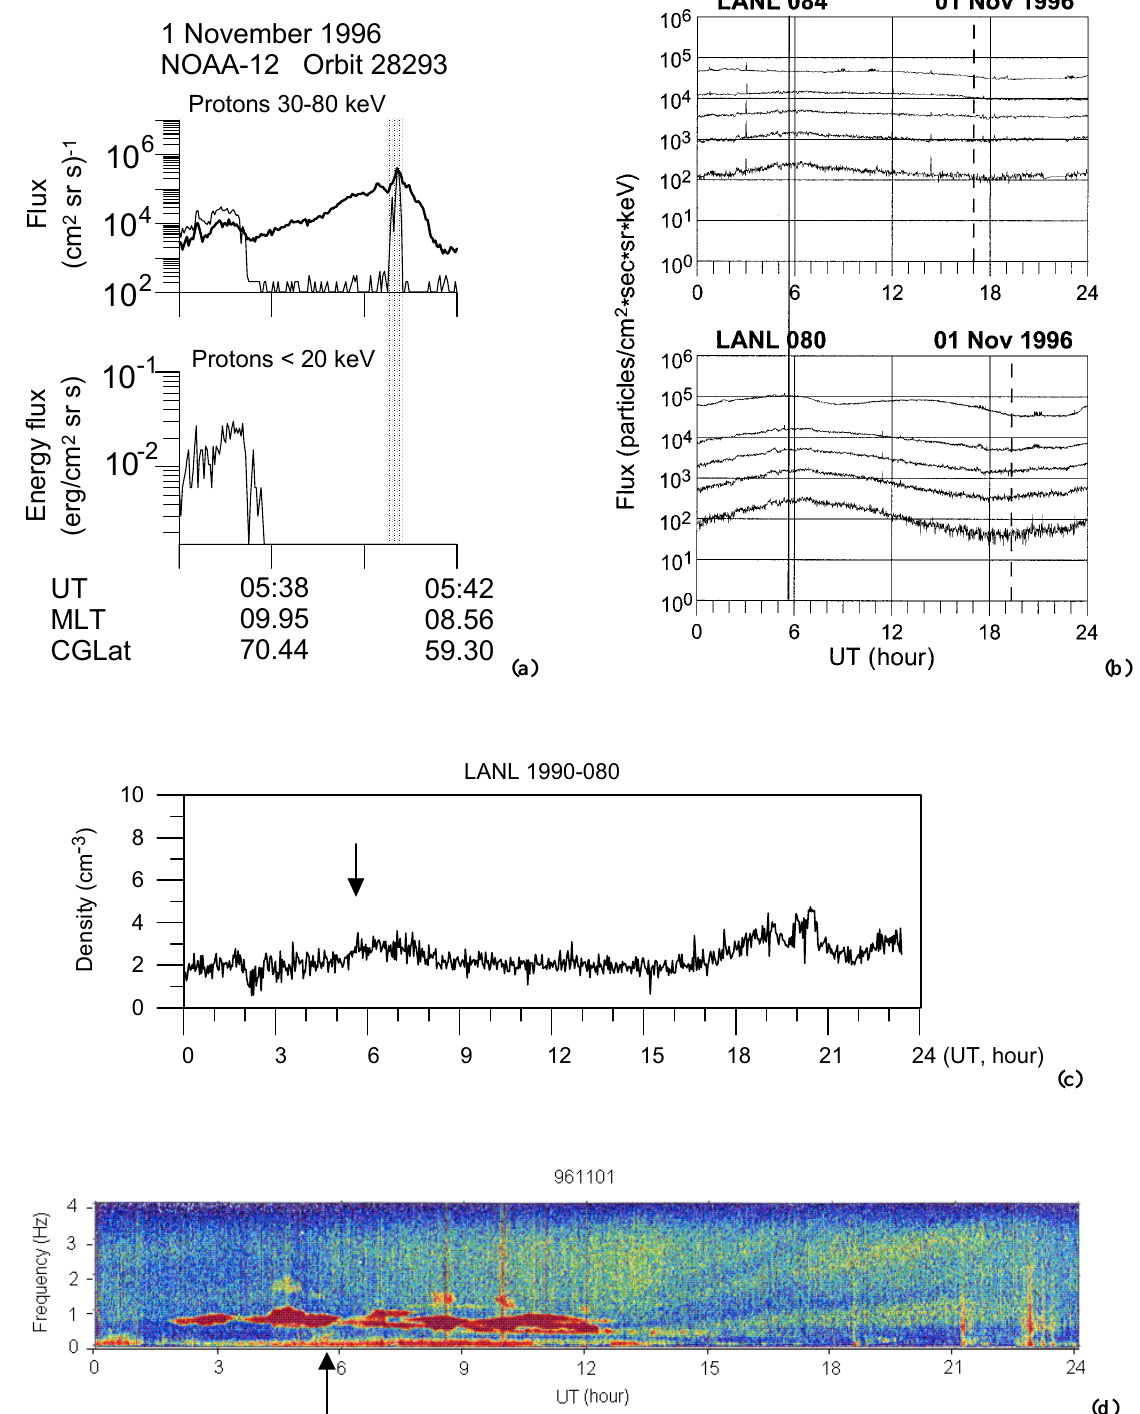
Fig. 6. The Type 1 event associated phenomena. (a) The NOAA-12 data showing the Type 1 event at 05:40:42UT on 01 November 1996. (b) The SOPA instrument data showing the energetic proton fluxes on board the LANL spacecraft. Only smooth variations are seen. (c) The LANL MPA instrument data showing the lack of cold plasmaspheric plasma at geosynchronous distance. (d) The daily spectrogram from SGO showing the dynamic spectra of geomagnetic variation in the range of 0.1–4Hz. Arrow marks the time of the NOAA-12 pass. The Pc1 pulsations are seen on the ground during the localized proton flux